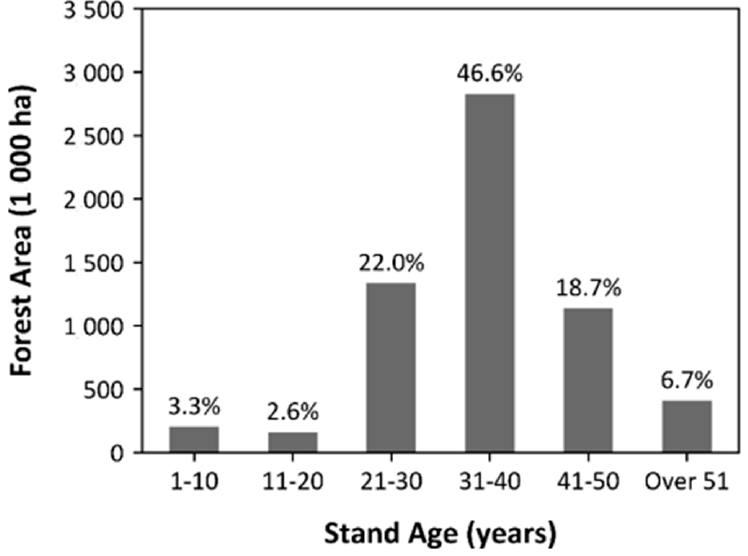
Figure 2. Age-class distribution of forest stands in South Korea as of 2019 [1]. If the current age-class imbalance persists, it would be challenging to produce a sustained timber yield in the long term. In addition, ecological forest functions, such as carbon absorption, water flow, and biodiversity, which change with forest aging [2], may be affected. Böttcher et al. [4] asserted that the forest age-class structure of a country determines how much carbon can be absorbed in present and future conditions. They demonstrated that the current age class distribution affects carbon levels and projected future carbon